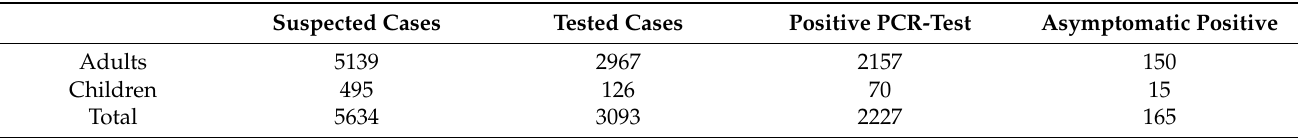
Table 2. Number of Suspected, Tested and COVID-19 Positive